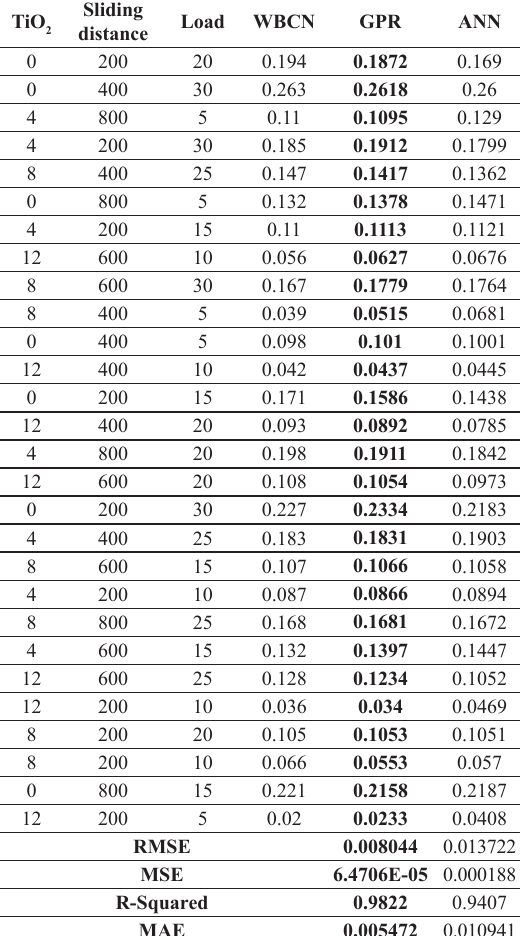
Table 5. The predicting results and the overall RMSE, MSE, R-Squared, and MAE for the proposed GPR model and the ANN model based on the 29 testing